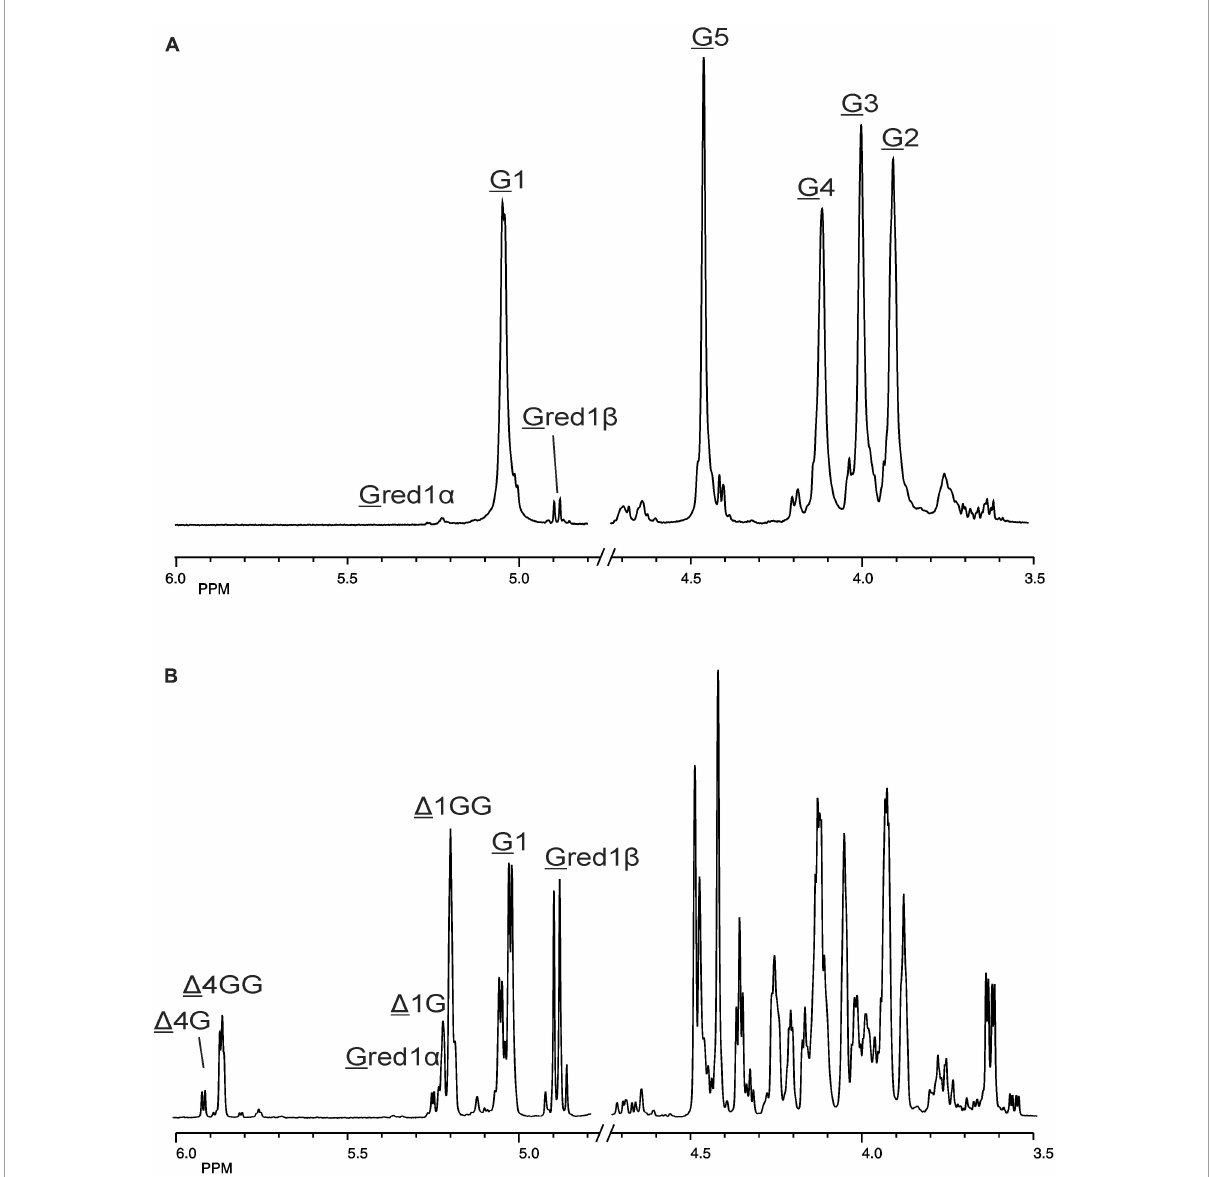
FIGURE5 1D 500-MHz 1 H NMR spectra (300K, D 2 O) of (A) the G-block alginate substrate before addition of the AlyRm3 enzyme, and (B) the oligosaccharide mixture generated after a 24-h incubation of the G-block alginate substrate with AlyRm3. Assignment according to Chen et al. (2018). G1 to G5 mean H-1 to H-5 of internal G residues; Gred1 α and Gred1 β mean H-1 of the reducing end α -G and β -G residue, respectively; (cid:49) 4G/ (cid:49) 1G and (cid:49) 4GG/ (cid:49) 1GG mean H-4/H-1 of (cid:49) in (cid:49) G β and (cid:49) G(G) n , respectively (for δ values, see Table 2 ).